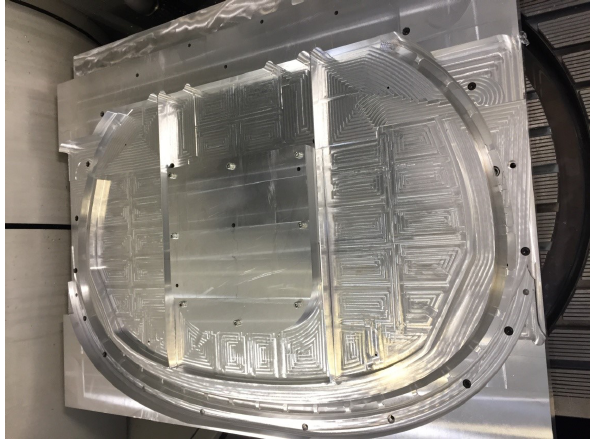
Figure 2: The frame mounting by technological bases and additional holes during the pocket